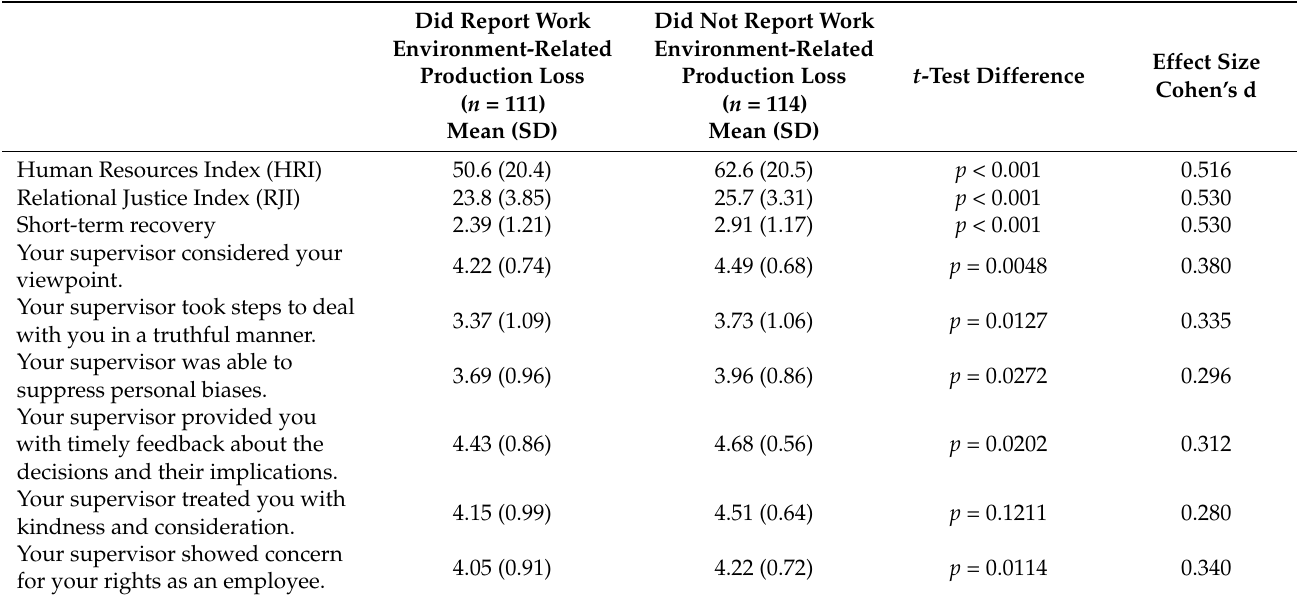
Table 4. Work environment-related production loss at